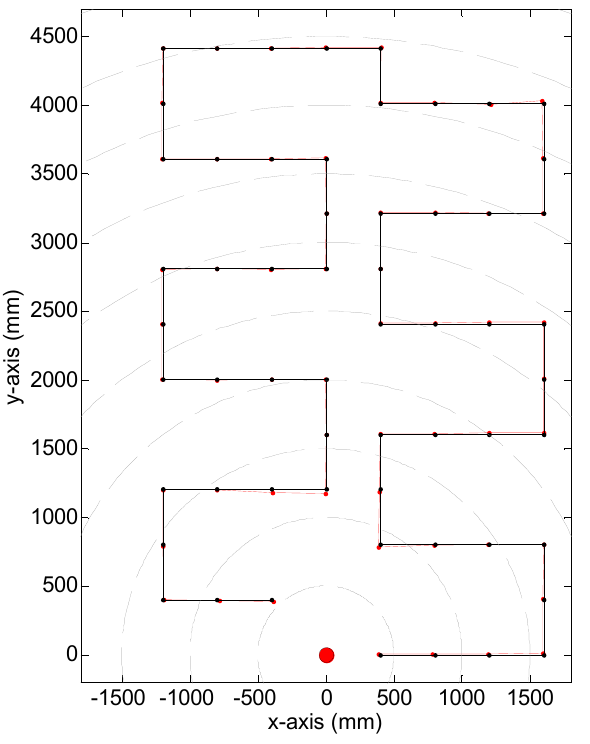
Figure 16. Comparison between the real and measured robot trajectory.